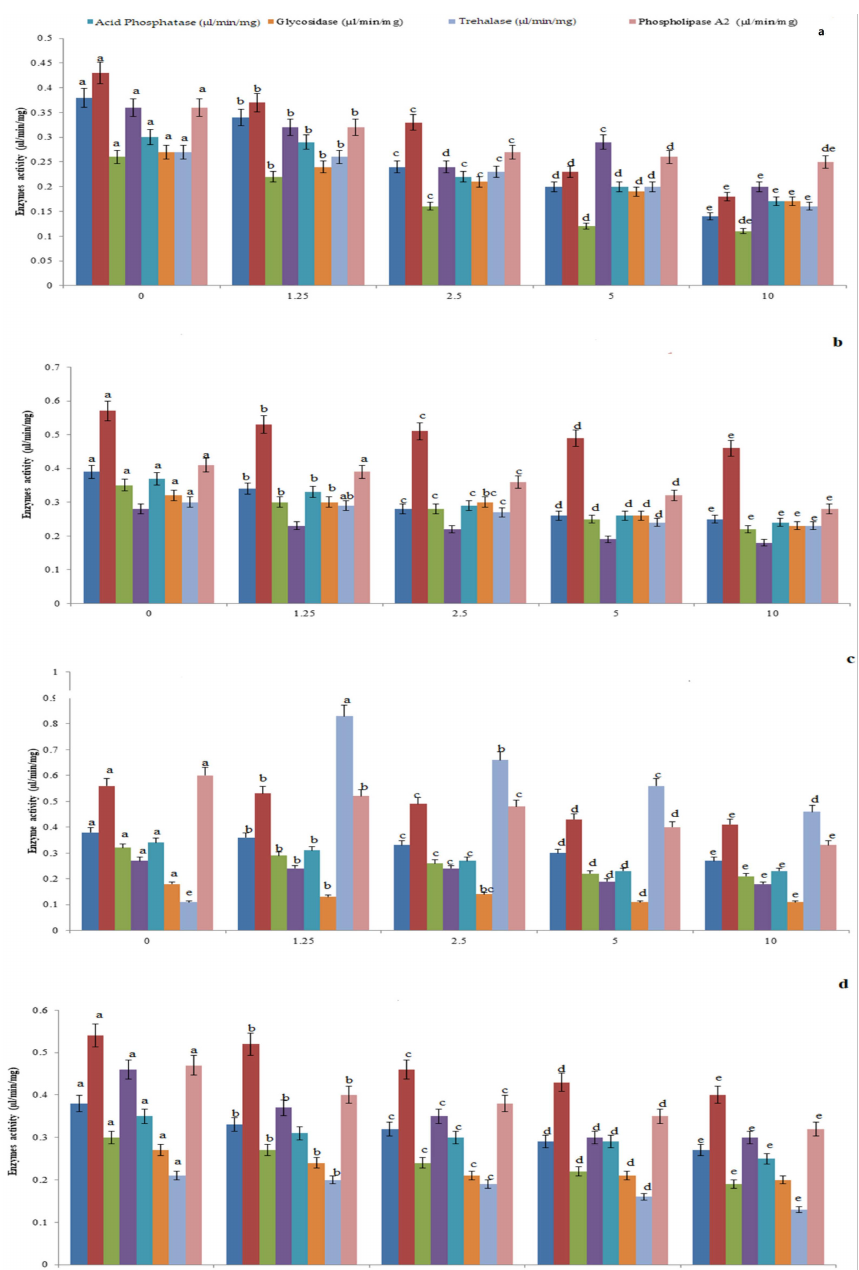
Figure 1. Whole insect body hydrolytic enzymes amylase, protease, invertase, lipase, acid phos- phatase, glycosidase, trehalase, and phospholipase A 2 levels of P. solenopsis exposed to P. glabura ( a ), I. carnea ( b ), A. squamosa ( c ), and J. adathoda ( d ) at different concentrations. Different letters (among the same concentration for each enzyme separately) above bars indicate significantly different means according to Tukey’s test ( p < 0.05). Bars indicate the standard error